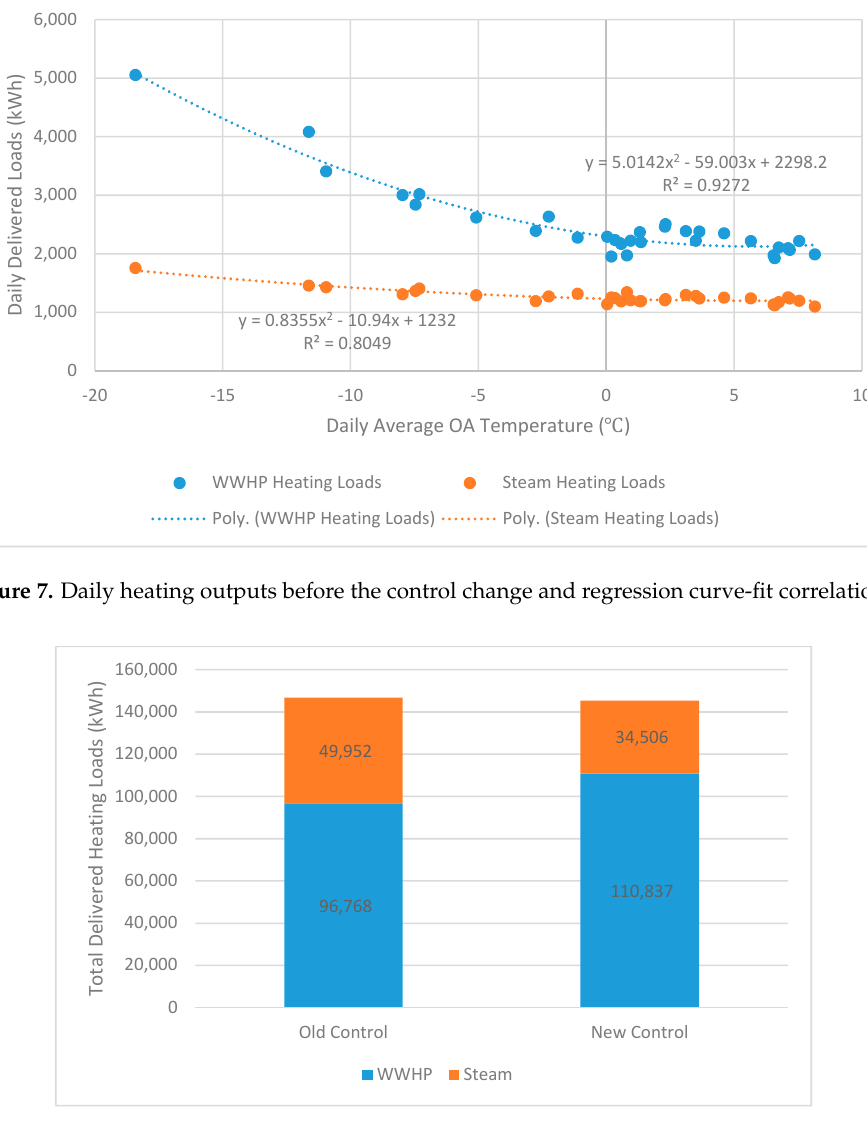
Figure 8. Energy use during 20 January through 28 February resulting from the two different controls.